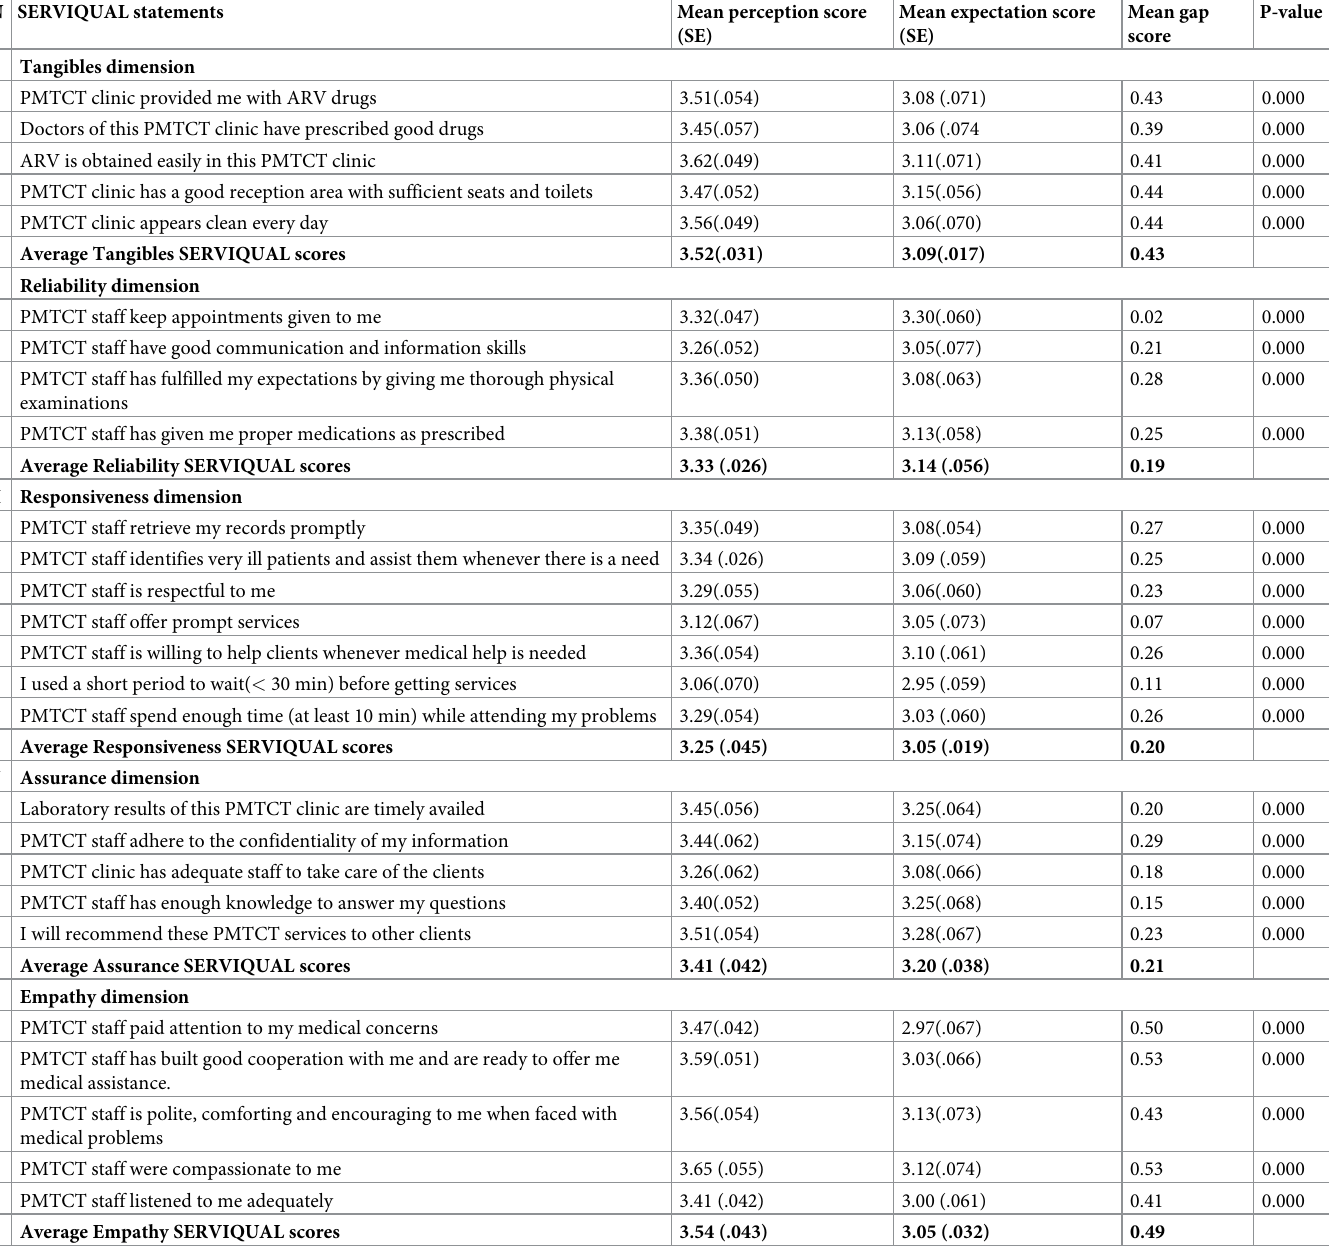
Table 3. Mean score and ranking of 5 service dimensions to assess the quality of care (n =